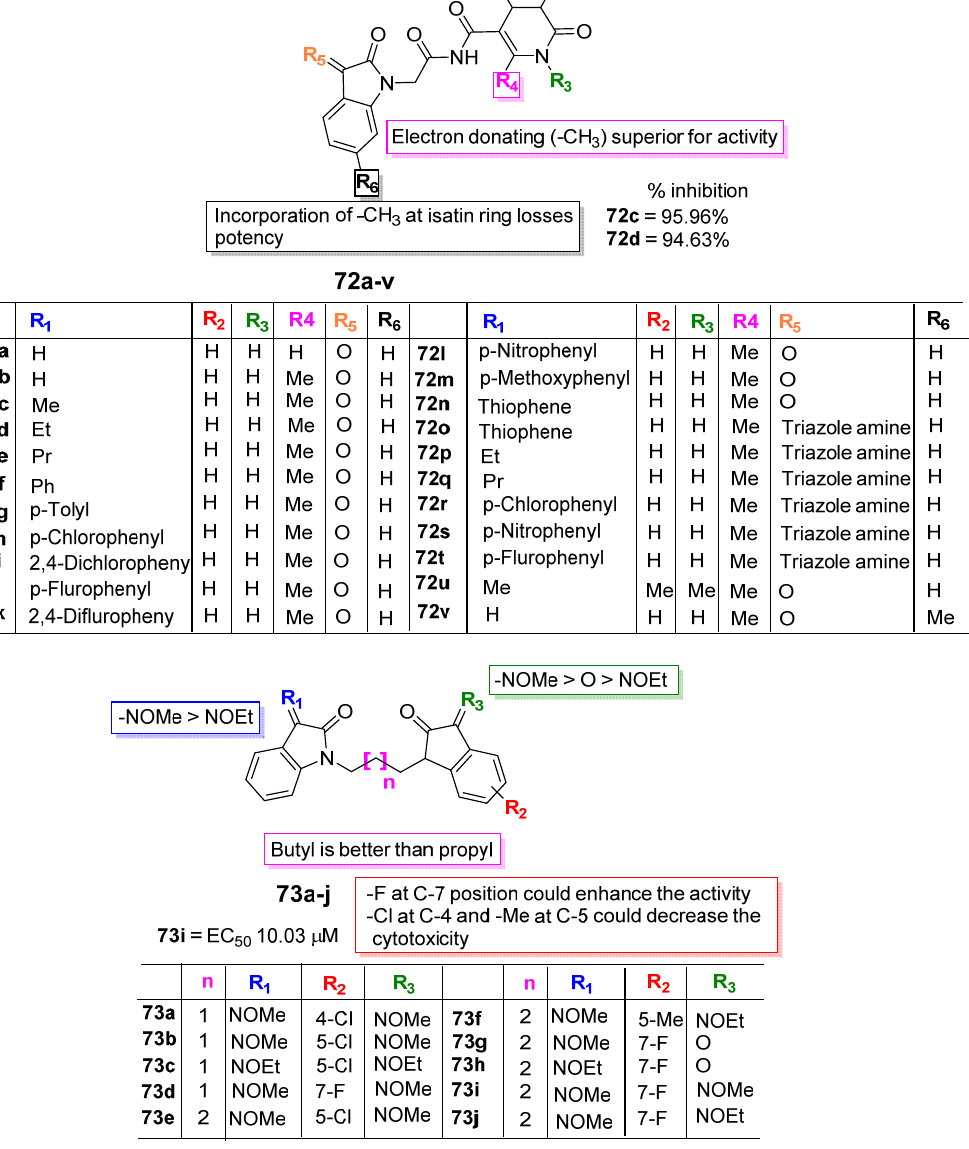
Figure 10. SAR outlines for anti-HIV isatin derivatives.